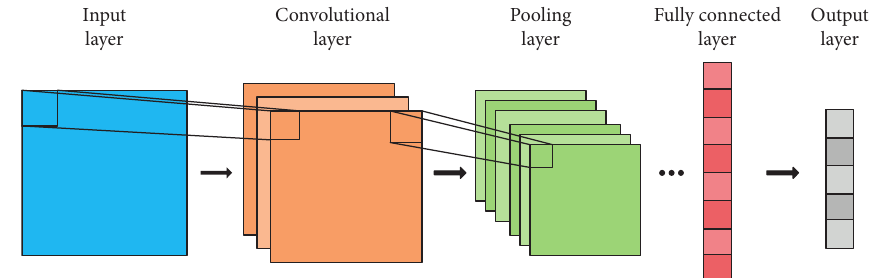
Figure 1: Structure of convolutional neural network.